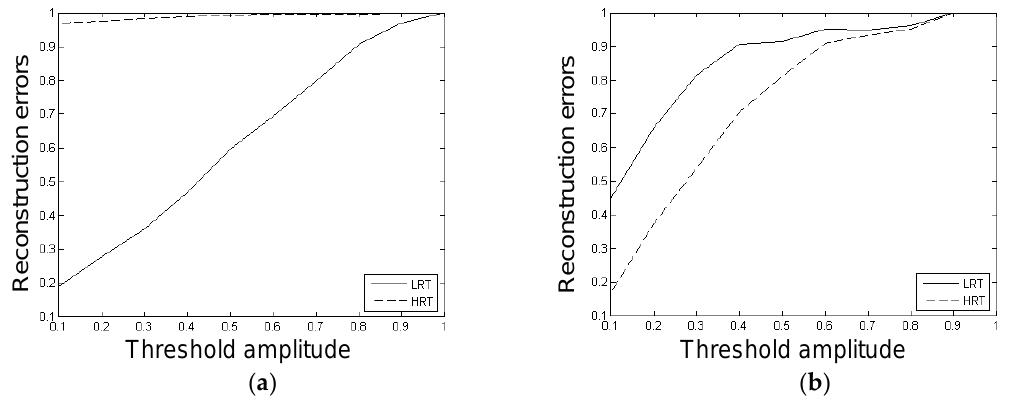
Figure 3. The curves of the reconstruction errors of ( a ) surface waves and ( b ) reflections against the threshold amplitude. LRT: linear Radon transform; HRT: hyperbolic Radon transform.